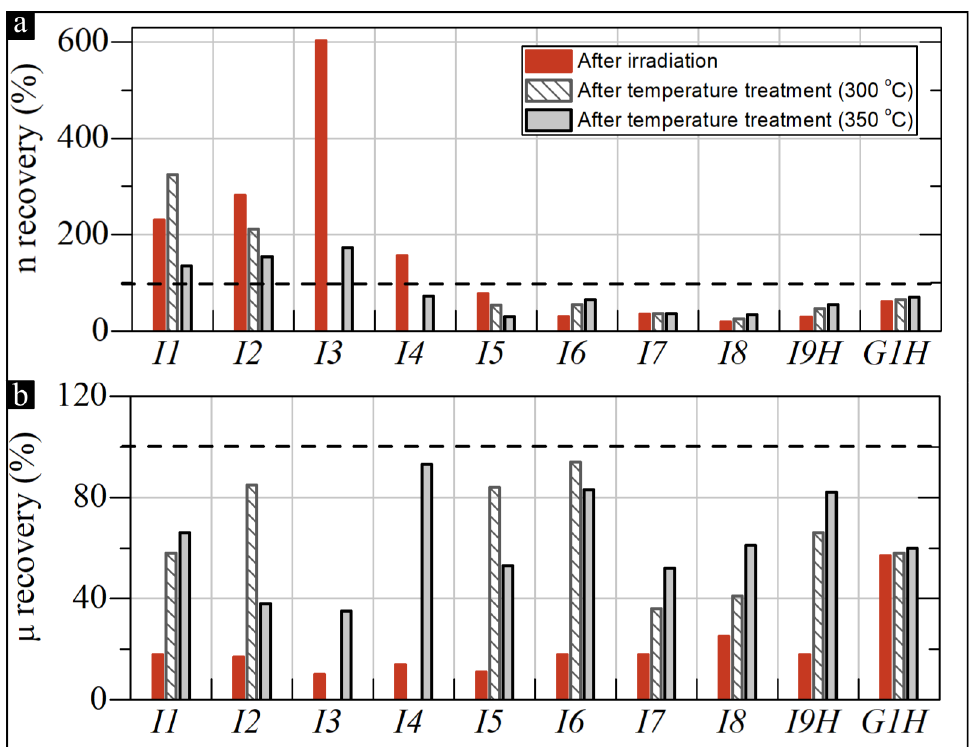
Figure 6. Recovery of charge carrier density ( a ) and mobility ( b ) in InSb and GR/SiC structures after the post-NR annealing cycles up to 300 °C and 350